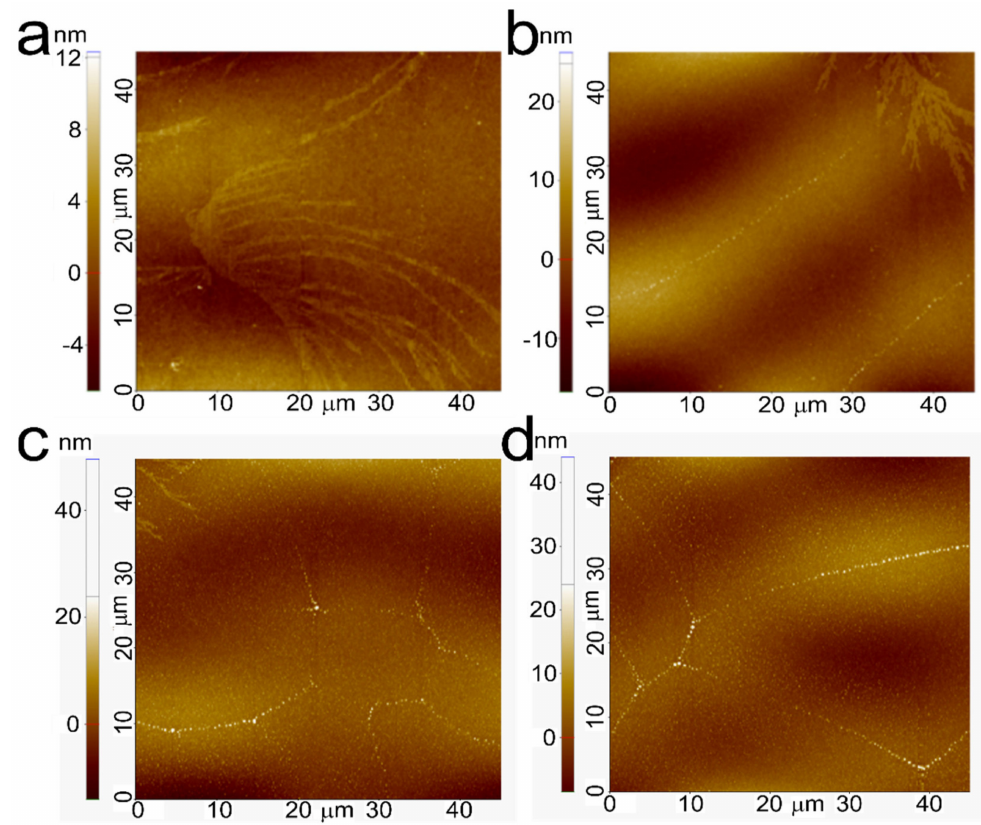
Figure 9. AFM topography images (45 × 45 µ m 2 ) of the PFO:Pt(salicylidenes) emissive layers, on top of the ITO|PEDOT:PSS|PVK layers: [Pt(salophen)] ( a , b ) and [Pt(sal-3,4-ben)] ( c , d ) at 0.1% and 0.5%,